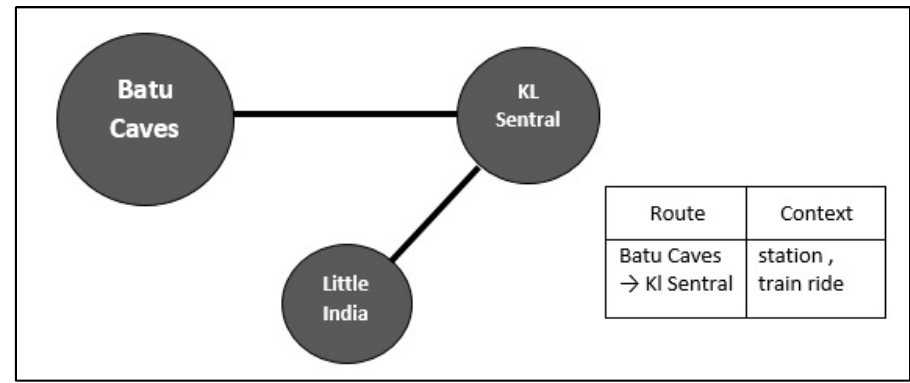
Figure 11. A POI graph with route context [45].